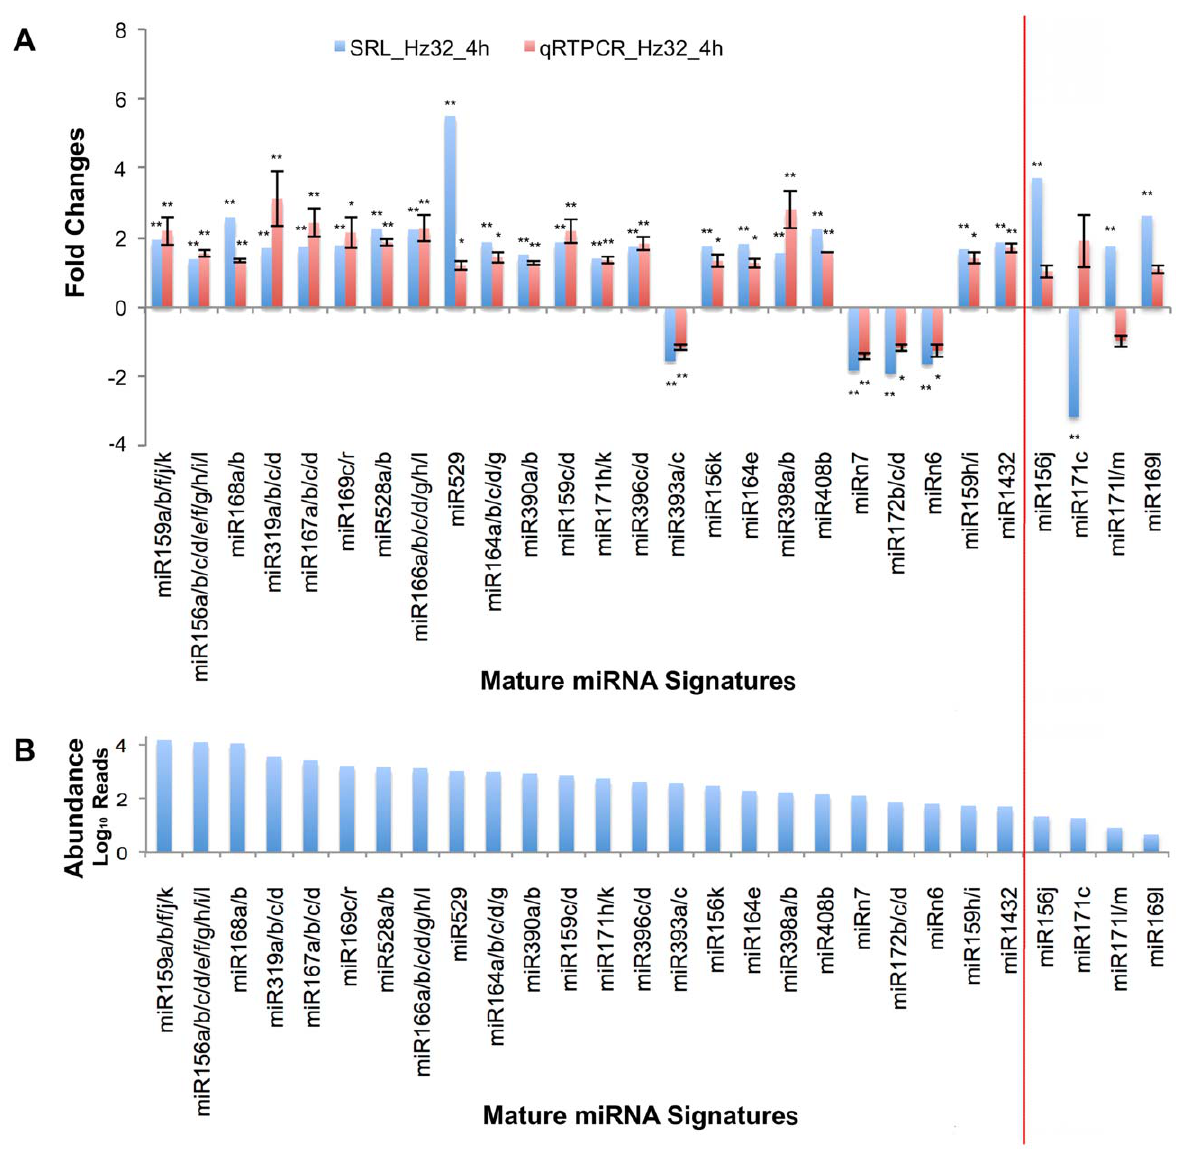
Figure 4. Expression profiles of 24 candidate miRNAs under hypoxia stress. Blue bars show the results of small RNA library in Hz32 under 4 h treatment. Red bars show the results of SLRT-PCR in Hz32 under 4 h treatment at 3 biological replicates. Vertical red line divides the expression profiles of 24 candidate miRNAs with 4 miRNAs (control expression profiles). Error bars show the standard deviation. Chi-square was applied on the small RNA library data and student t-test was performed on SLRT-PCR results. ** denotes the p value , 0.01 and * denotes the p value ,